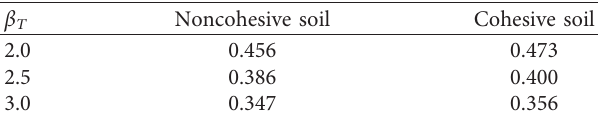
Table 7: Recommended values of resistance